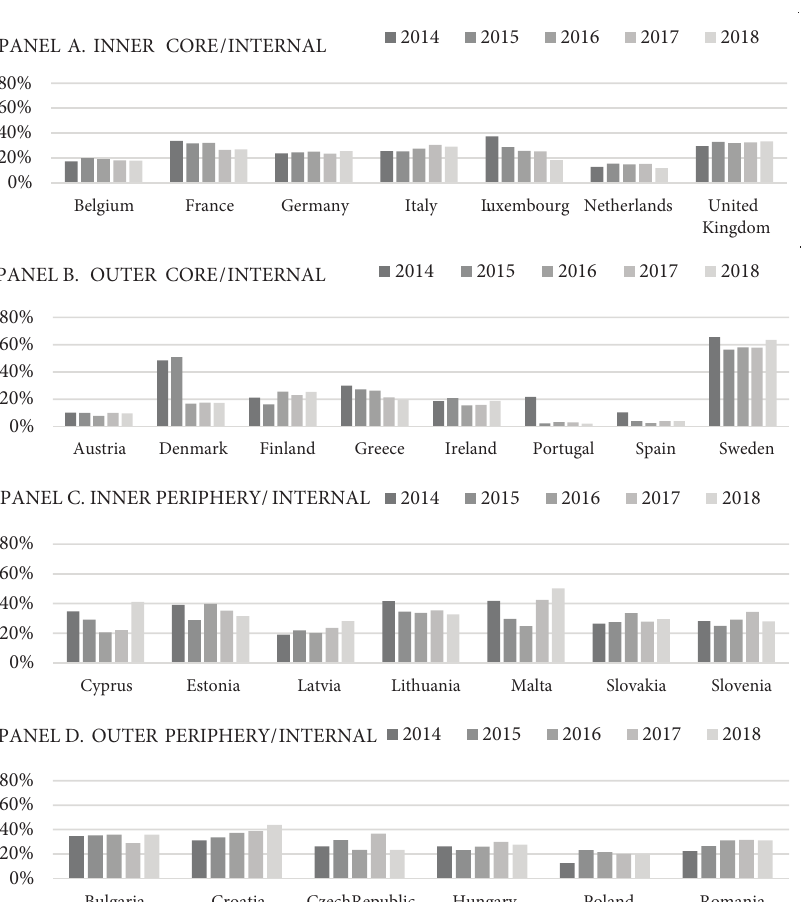
PANEL A. INNER CORE / INTERNAL